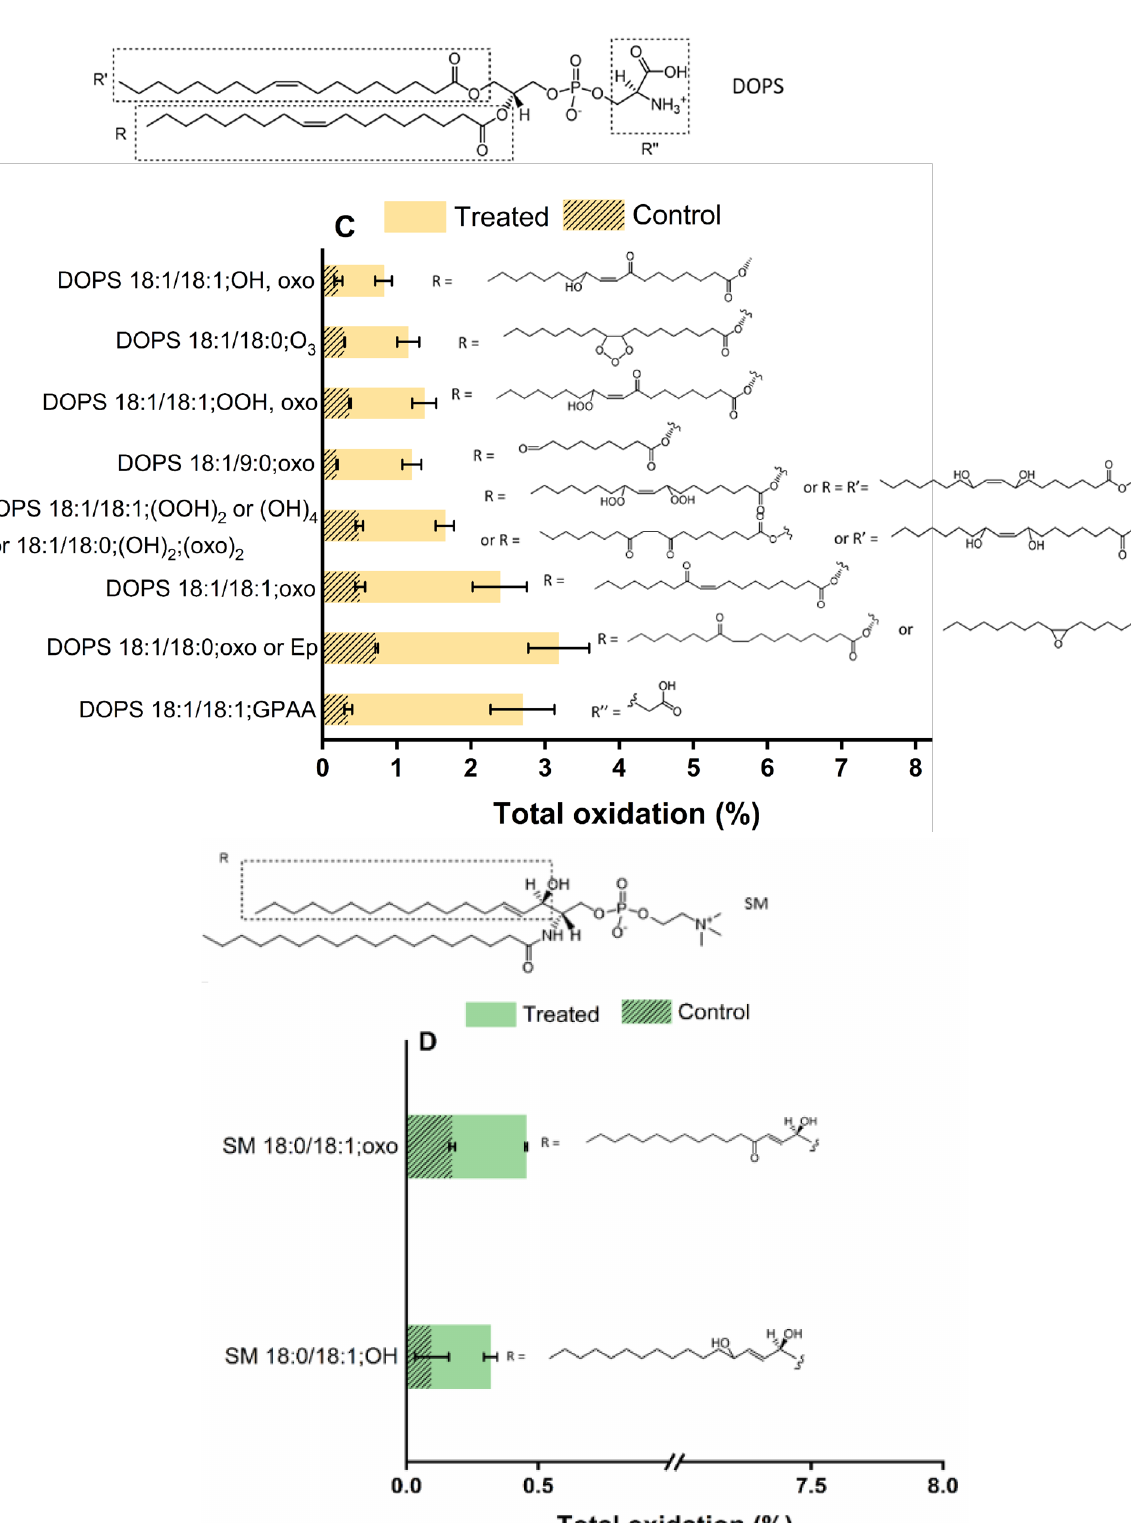
Figure 7. Oxidation products of ( A ) POPC, ( B ) DOPE, ( C ) DOPS, and ( D ) SM (d18:1/18:0) after 15 min plasma treatment compared to the auto-oxidation (control). The total oxidation is calculated as the peak area of each lipid oxidation product divided by the peak area of parent lipid in the same sample. EP: epoxy, GPAA: glycerophospholipid acetic